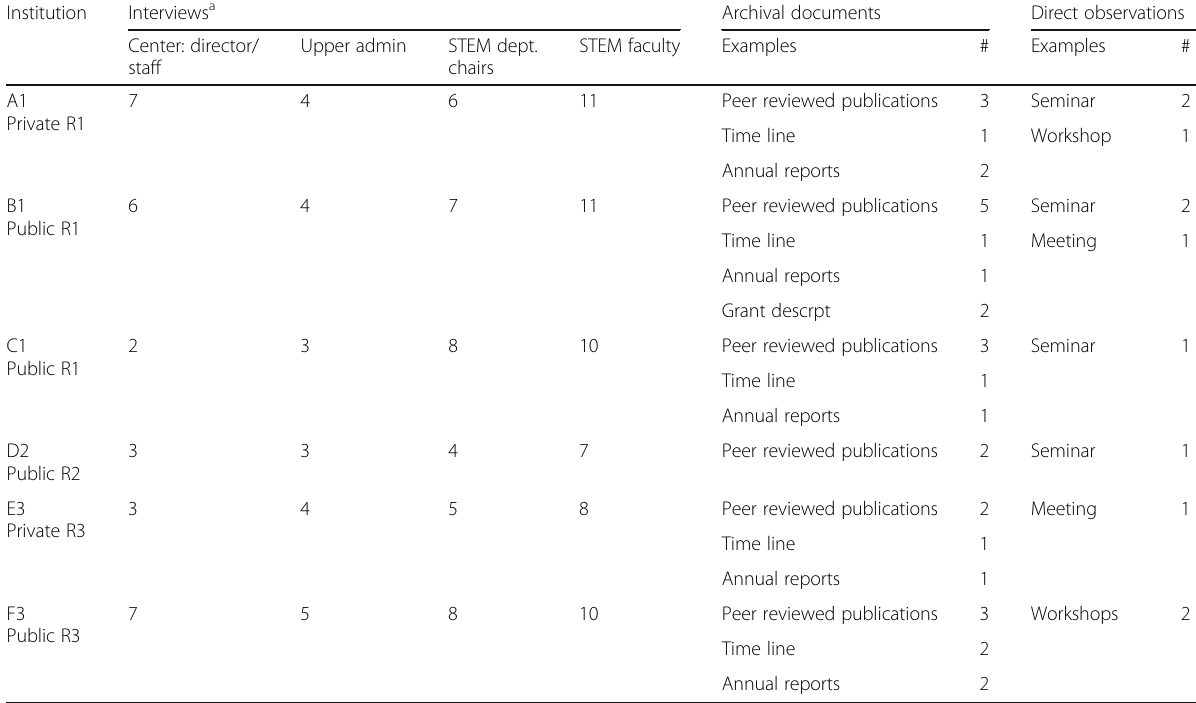
Table 2 Sources of data from individual site visits